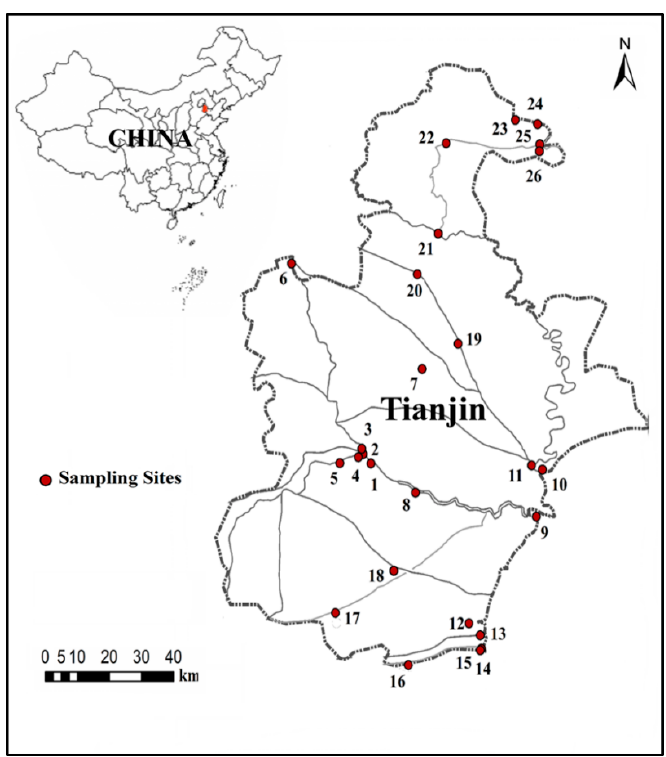
Figure 1. Locations of sampling sites in Tianjin City in China.